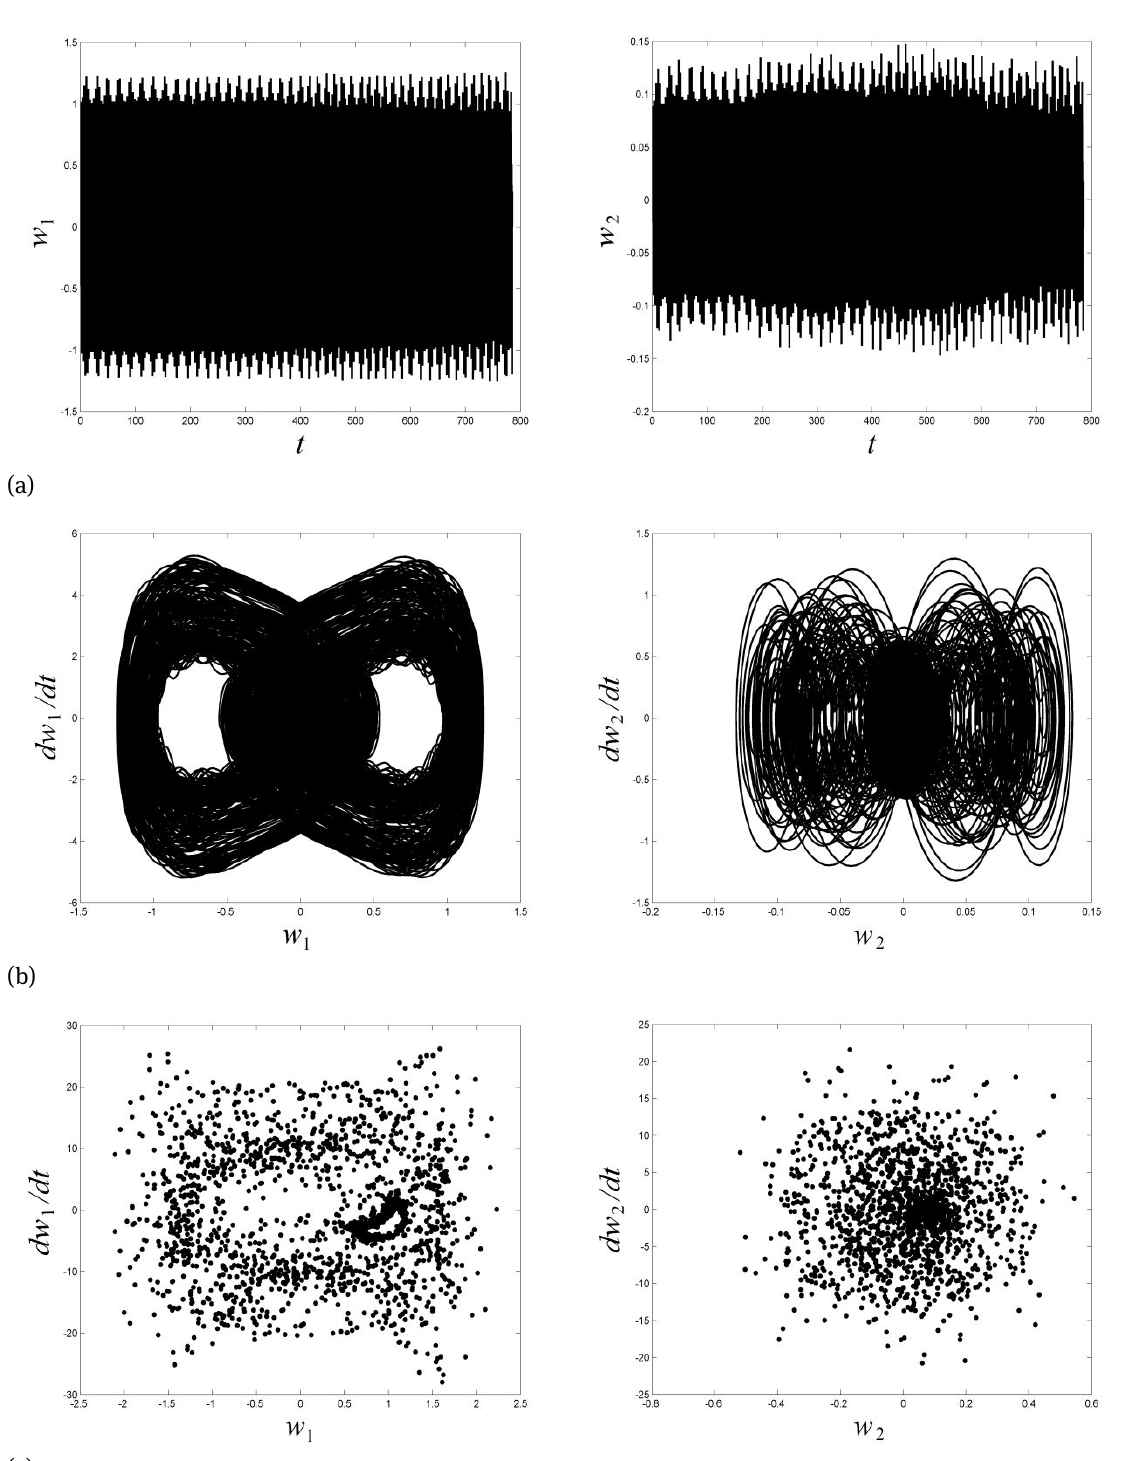
Fig. 6. Chaotic behaviors of the cantilever beam system shown in wave diagrams (a), phase diagrams (b) and Poincaré maps (c). q